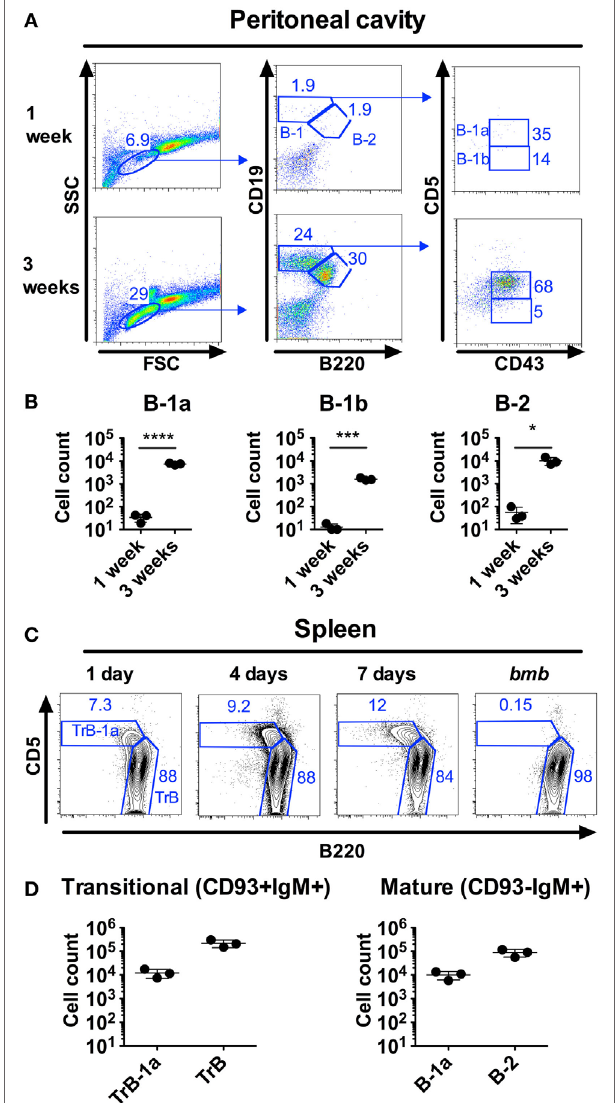
FigUre 1 | B-1 cells are found in the spleen but not in the peritoneal cavity of neonatal mice. Neonatal mice were stained by flow cytometry for B-1 and B-2 cells, defined as CD19hiB220loCD43 + CD5 + / − and CD19 + B220 + , respectively. (a) Representative staining of C57BL/6 wild type (wt) peritoneal cells from 1 to 3 weeks old mice. (B) Number of cells from the different B cell subsets in peritoneal flushes from 1 week to 3 weeks old wt mice. (c) Representative staining of splenic transitional B-1a (TrB-1a, CD93 + IgM + CD5 + B220lo) and transitional B (TrB, CD93 + IgM + CD5 − B220 + ) cells at different time points. As negative controls for transitional B-1a cells, neonatal mice with the bumble ( bmb ) mutation in the gene encoding I κ BNS were included [these were previously demonstrated to lack TrB-1a, (21)]. (D) TrB-1a, TrB cells (left panel), and mature B-1a and B-2 cells (right panel) in the spleen of 1-week-old wt mice. Results are representative of at least two independent experiments and graphs display mean ± SD. Statistically significant differences are indicated by *, ***, and **** denoting p < 0.05, p < 0.001, and p < 0.0001, respectively by unpaired t